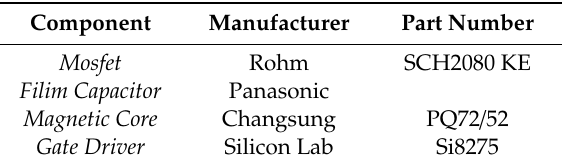
Table 2. Component for the Hardware Test.